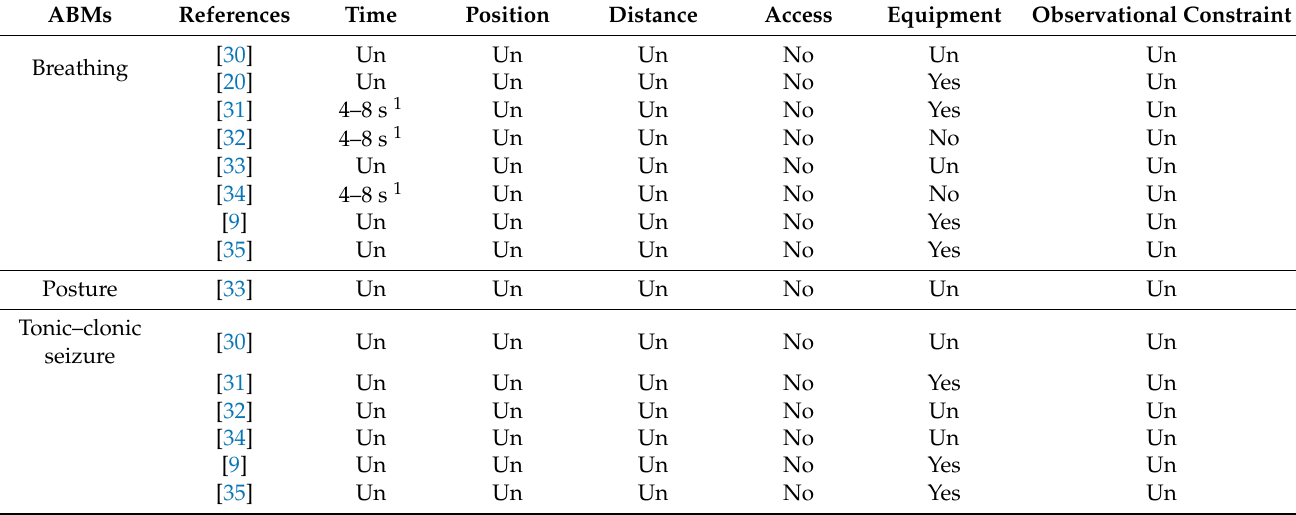
Table 4. Critical evaluation of the feasibility of ABMs derived from the literature review—Physical Aspects of Feasibility. For each study, we report the study characteristics and the feasibility aspects that are directly described (e.g., the use of electroencephalogram (EEG)) or that can be derived from the information provided (e.g., seconds needed for assessing the presence of rhythmic breathing or the need to touch the